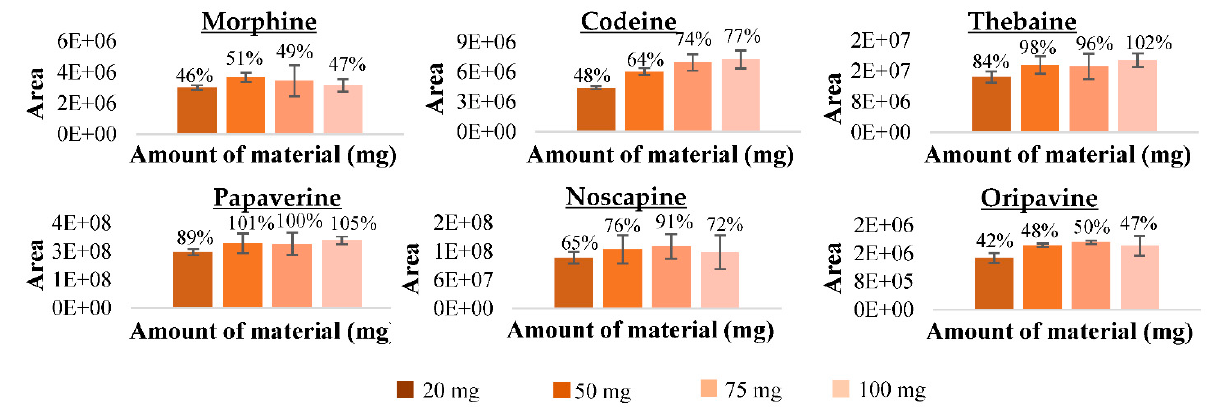
Figure 4. Effect of the different amounts of material in the optimised MSPE procedure with Fe 3 O 4 @SiO 2 @mSiO 2 material.